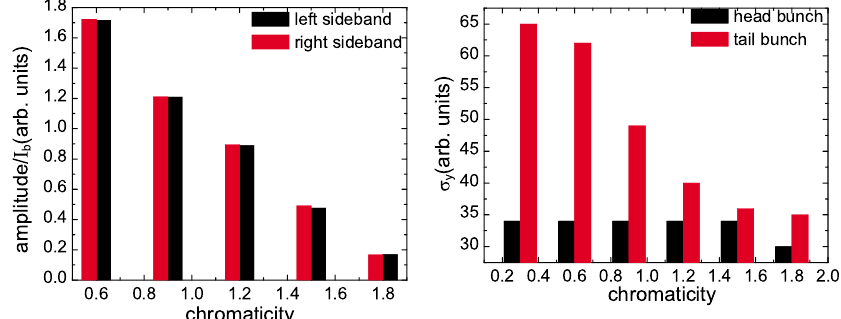
FIG. 10. (Color) Amplitude of the sideband (left) and the bunch size (right) versus